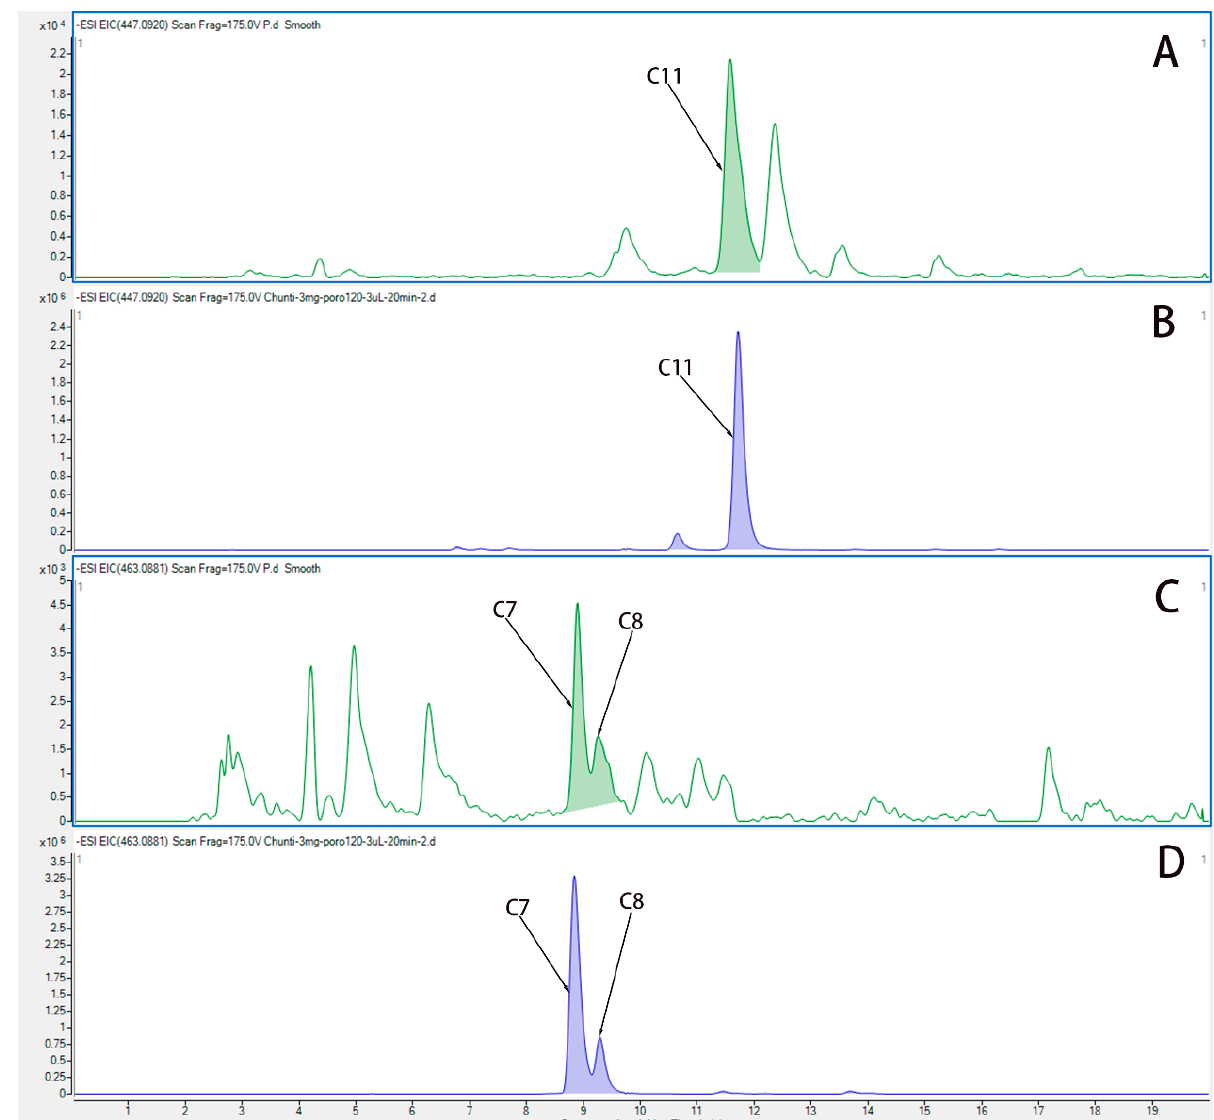
Figure 4. The EIC chromatogram of components in plasma from rats after administration of HP. ( A ) The EIC chromatogram of quercetin (C11) in plasma from rats after the last administration. ( B ) The EIC chromatogram of quercetin (C11) in water extract of HP. ( C ) The EIC chromatogram of Hyp (C7) and isoquercetin (C8) in plasma from rats after the last administration. ( D ) The EIC chromatogram of Hyp (C7) and isoquercetin (C8) in water extract of HP.